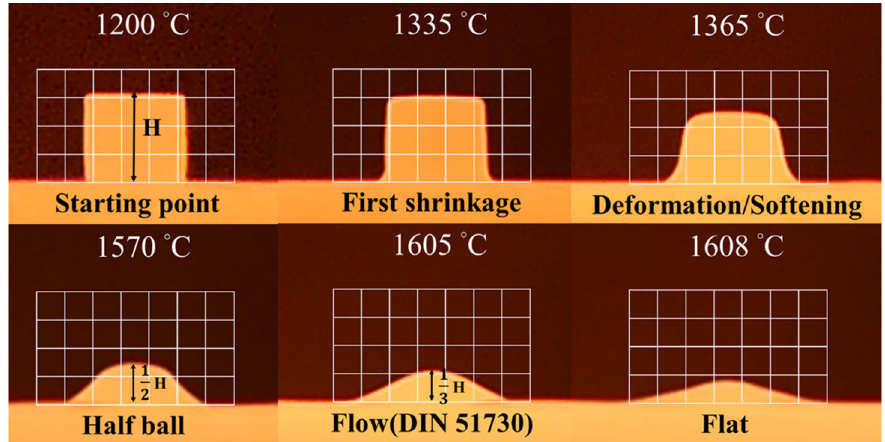
Figure 7. High-temperature optical images of sample B1.